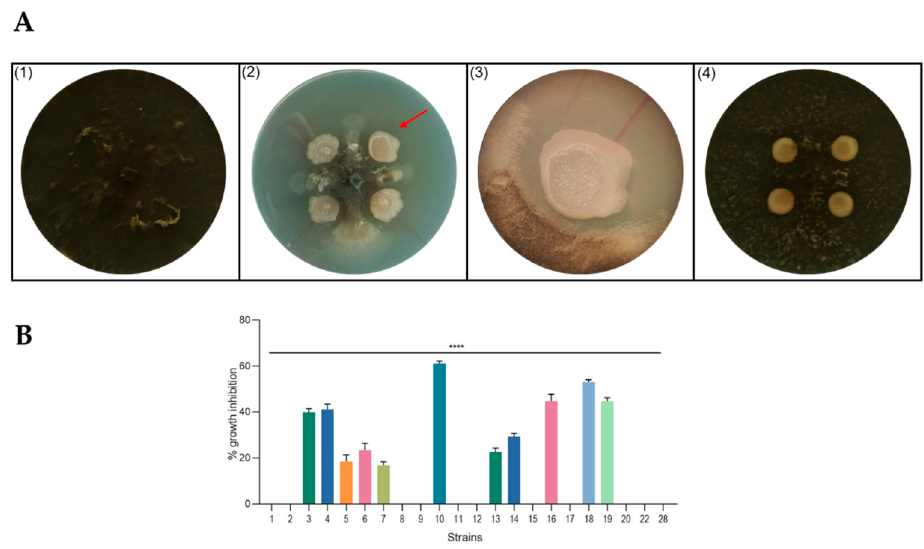
Figure 2. Antagonism assays in solid medium. ( A ) Representative photographs of dual-culture assay for in vitro inhibition of mycelial growth of M. phaseolina by isolated strains. (1) M. phaseolina (control plate); (2) example of active strain (RHFS10) against M. phaseolina growth; (3) images of interaction zone of RHFS10 strain and M. phaseolina acquired with a stereoscopic microscope (10 × magnification); (4) example of inactive strain (RHFS28) against M. phaseolina growth; red arrow in panel 2 indicates the interaction zone magnified in panel 3. ( B ) Inhibition of fungal growth reported as the percentage reduction in the diameter of the fungal mycelia in the treated plate compared to that in the control plate. All experiments were performed in triplicate with three independent trials. Data are presented as means ± standard deviation ( n = 4) compared to control M. phaseolina grown without bacteria. For comparative analysis of groups of data, one-way ANOVA was used and p values are presented in the figure: ****: extremely significant < 0.0001.